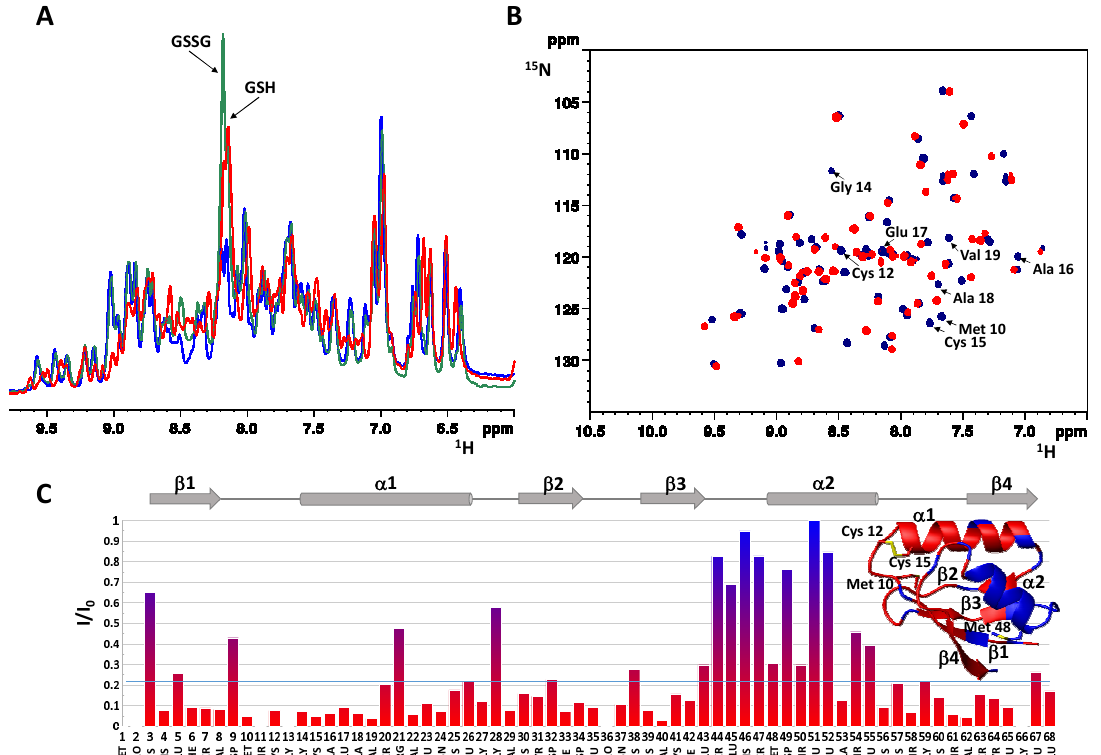
Figure 2. ( A ) Comparison of 1D 1 H spectra of apo Atox1 in the reduced form (blue) and after 1 h (green) and 12 h (red) incubation with three equivalents of GSSG. The signals of the amide proton of the glycine of GSSG and GSH are indicated by arrows. ( B ) Overlay of 2D 1 H, 15 N HSQC spectra of apo Atox1 in the reduced form (blue) and after 12 h incubation with GSSG (red). The arrows indicate cross-peaks of residues close to the CxxC motif for reduced apo Atox1. ( C ) Plot of intensity ratio (I / I 0 ) versus the primary sequence, calculated at resonance positions of backbone amides of reduced apo Atox1, using 1 H, 15 N HSQC spectra recorded after 12 h of incubation with GSSG (I) and in the absence of GSSG (I 0 ). The secondary structure elements are shown on top. (Inset) Residues with I / I 0 above average are mapped in blue on the structure of oxidized Atox1 and residues with I / I 0 below average are mapped in red. The ribbon diagram was generated with the program MOLMOL.